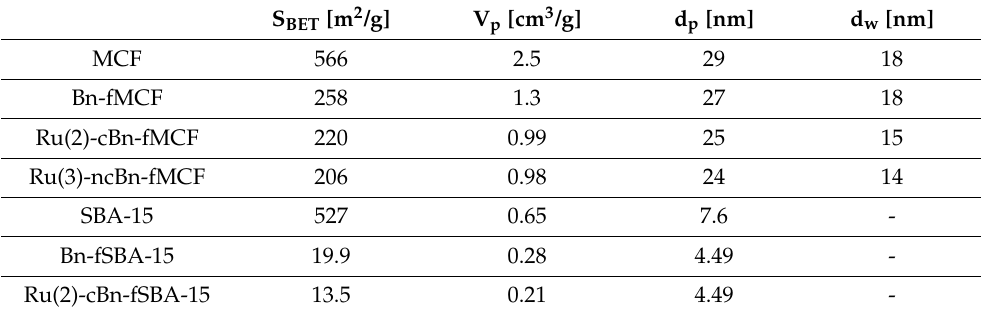
Description of columns: multilayer adsorption (S BET ) pore volume (V p ), pore diameter (d p ) and window diame- ter